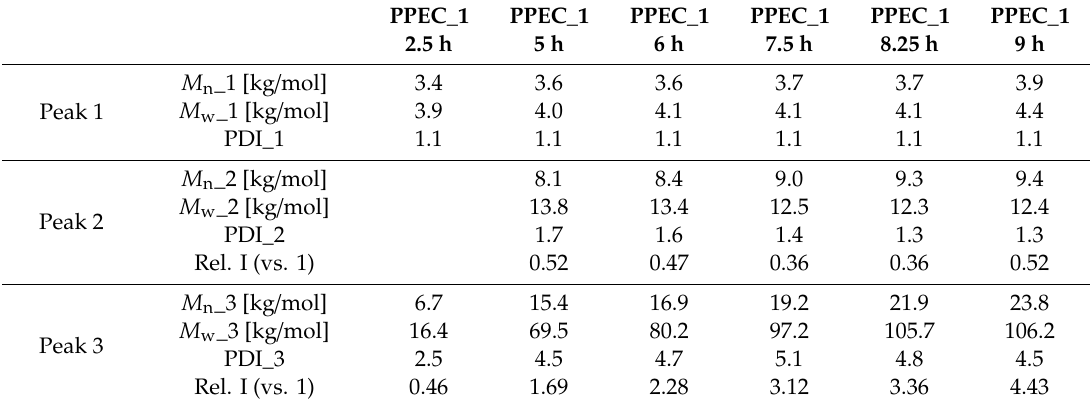
Table 5. Molecular weights of PPEC_1 (Entry 21) samples (peak fit using